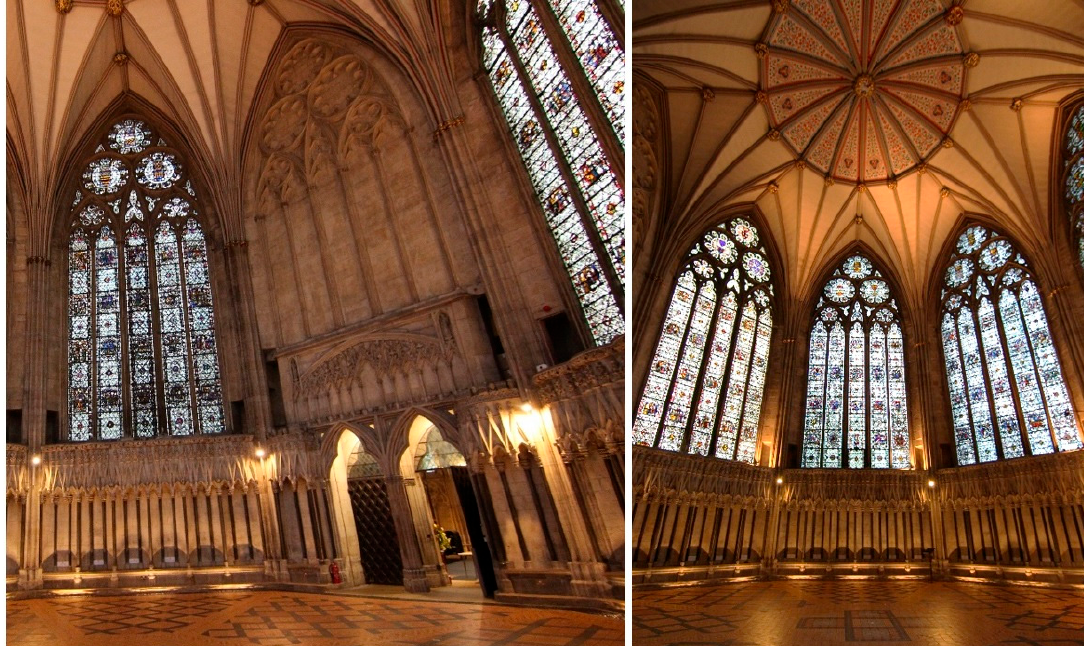
Figure 2. York Minster’s Chapter House interior views: looking to the West side ( left ) and looking to the East side ( right ).